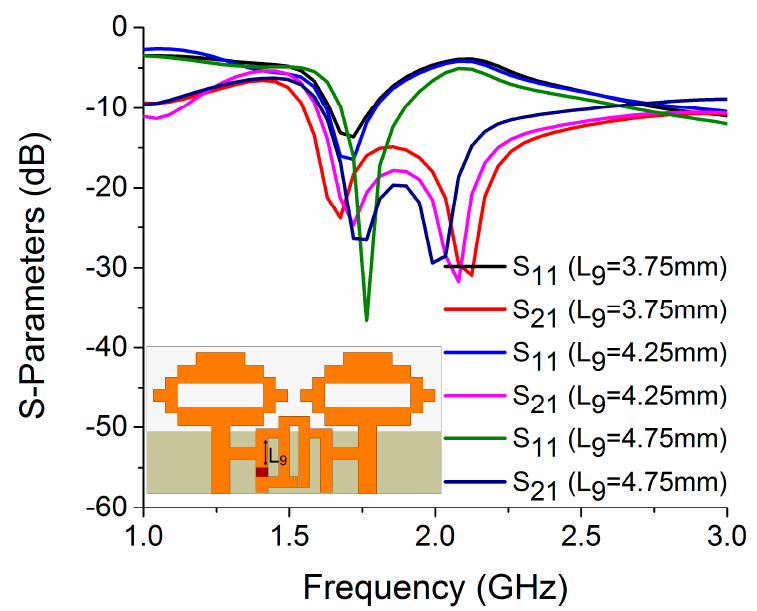
Figure 22. Influence of L 9 on S-parameters.